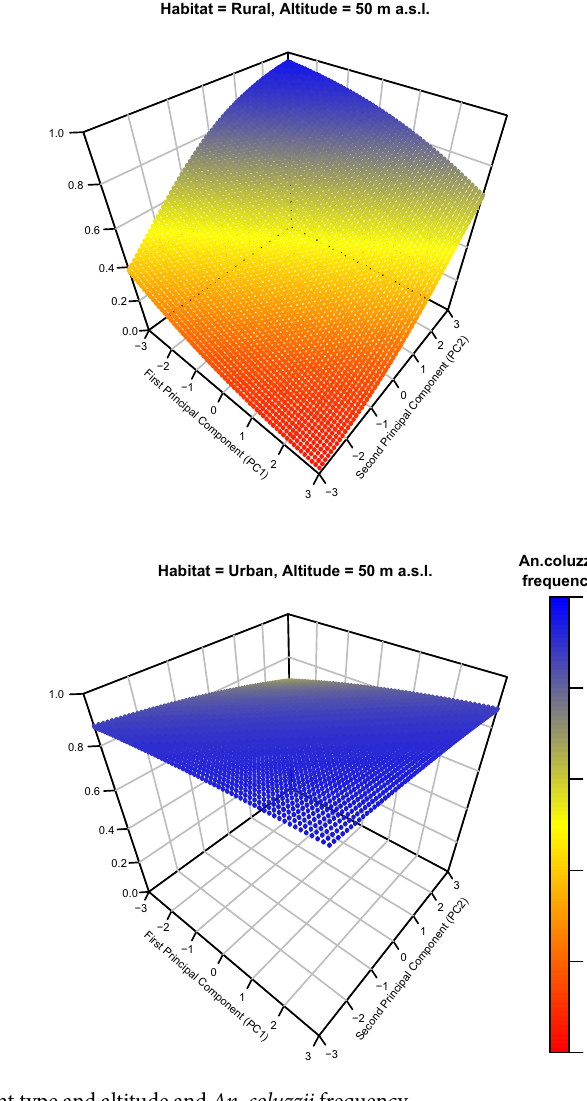
Figure 3. Association between environment type and altitude and An. coluzzii